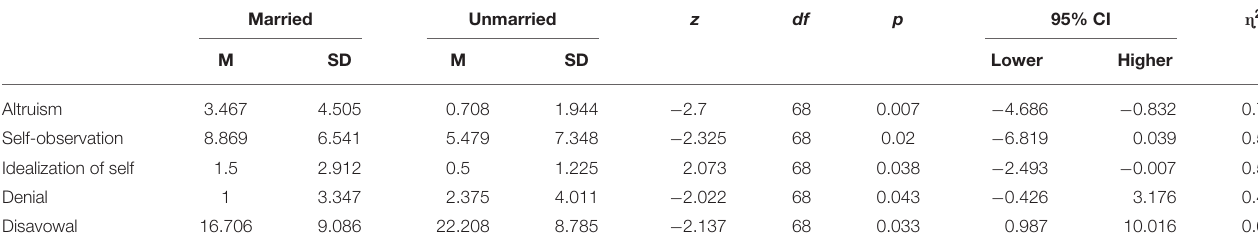
TABLE 4 | Differences in defense mechanism between married and single patients with BC. Married Unmarried z df p 95% CI ï 2 M SD M SD Lower Higher Altruism